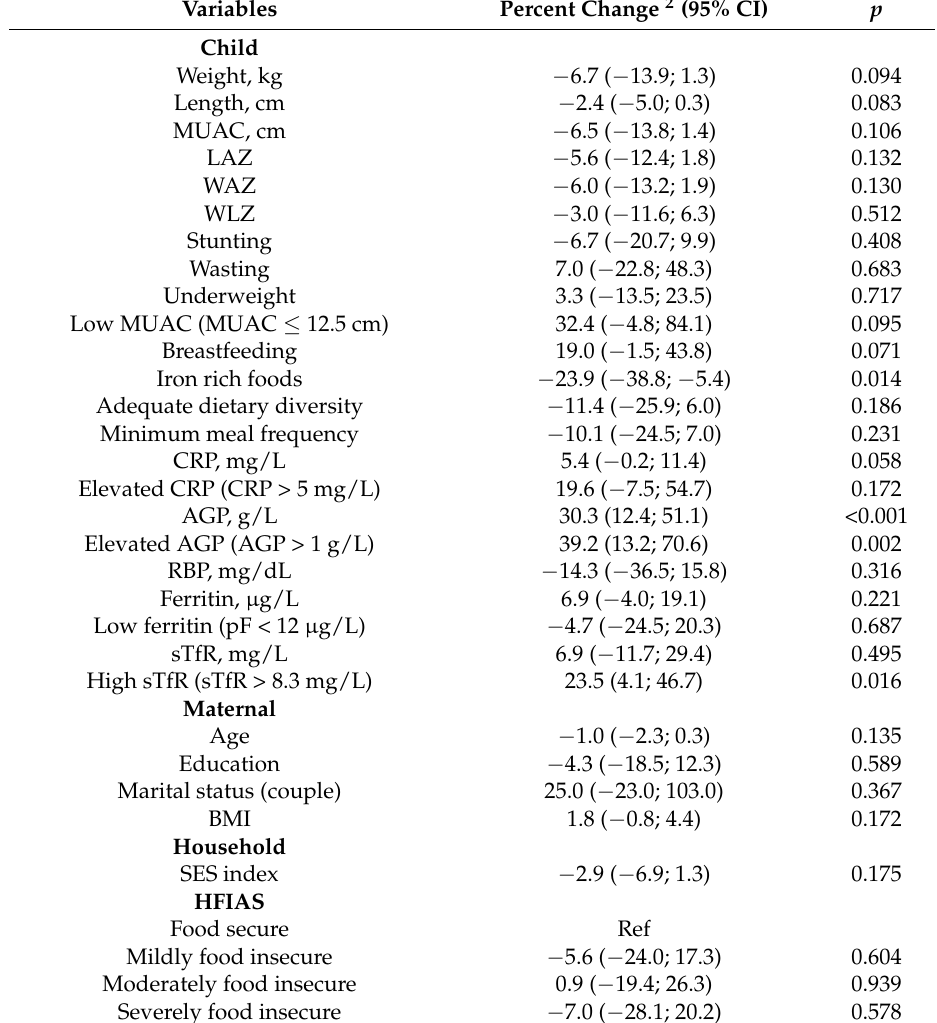
Table 3. Associations between baseline HCC and potential risk factors among Laotian children 1